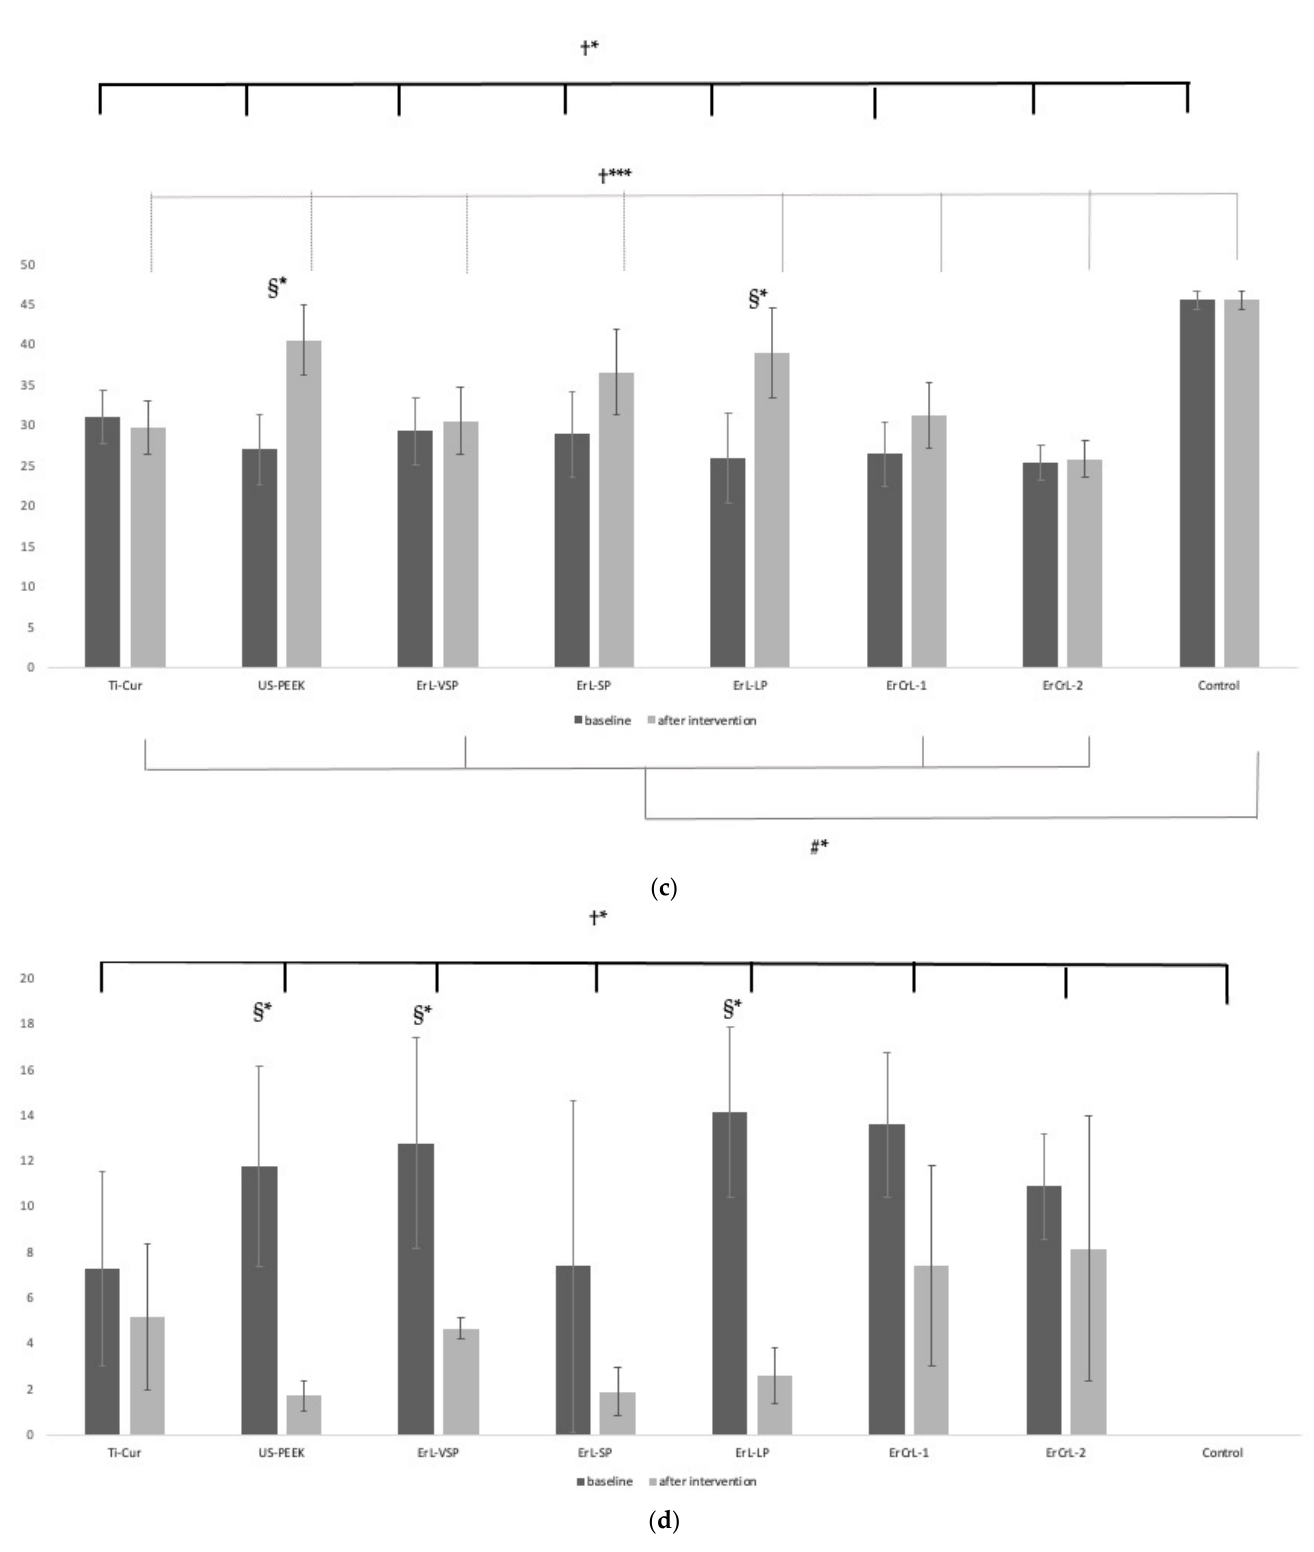
Figure 9. ( a ) EDX % C intragroup and intergroup comparisons; ( b ) EDX % Ti intragroup and intergroup comparisons; ( c ) EDX % O intragroup and intergroup comparisons; ( d ) EDX % N intragroup and intergroup comparisons. §: Paired Sample t Test †: One-Way ANOVA #: POST HOC Tukey HSD p -value * < 0.05 ** < 0.01 *** < 0.001.